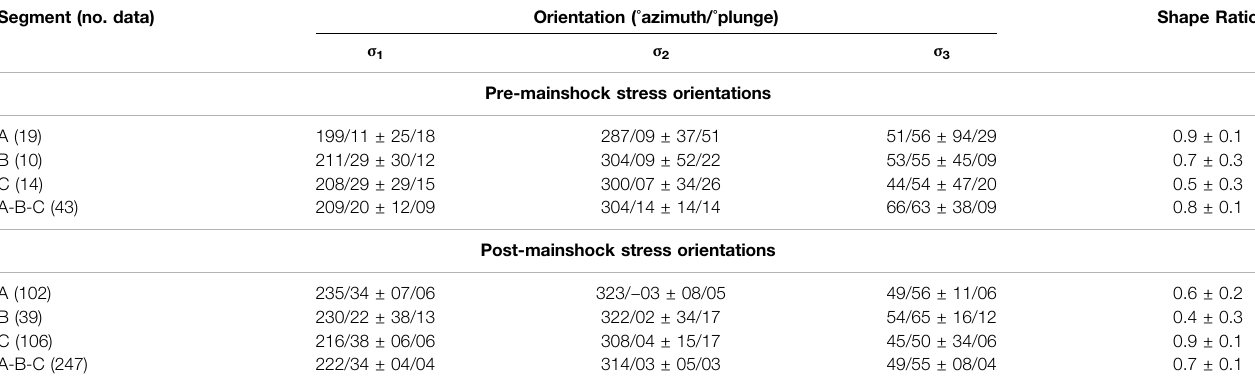
TABLE 1 | Stress inversion results for the principle stress directions and shape ratios for pre-mainshock and post-mainshock intervals. The indicated uncertainties are estimated by taking half the width of the 95% quantile interval of the corresponding bootstrap-resampled distribution. Segment (no.